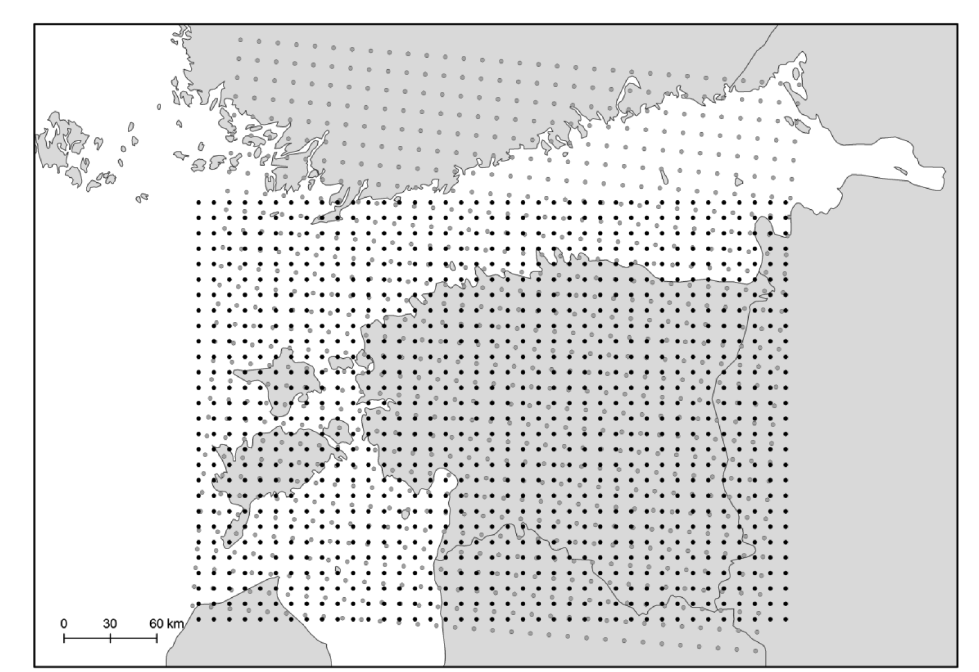
Fig. 1. The extent and resolution of the KAUR ensemble domain (grey dots) and recalculated map used for the KATI project with a new extent (black dots).